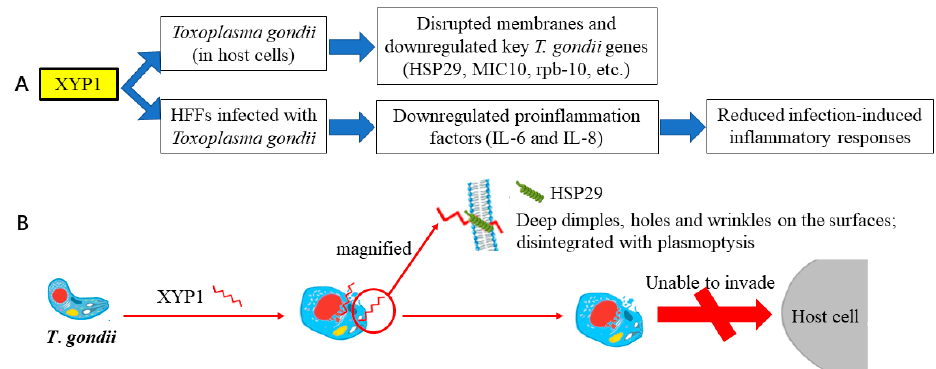
Figure 8. Proposed mechanism of XYP1. ( A ) Proposed mechanism of the anti- T . gondii action and protective effect on HFFs of XYP1. ( B ) Proposed mechanism of the anti- T . gondii action. XYP1 may downregulate the expression of HSP29, and consequently disrupt the tachyzoite membrane and inhibit its invasion and proliferation.